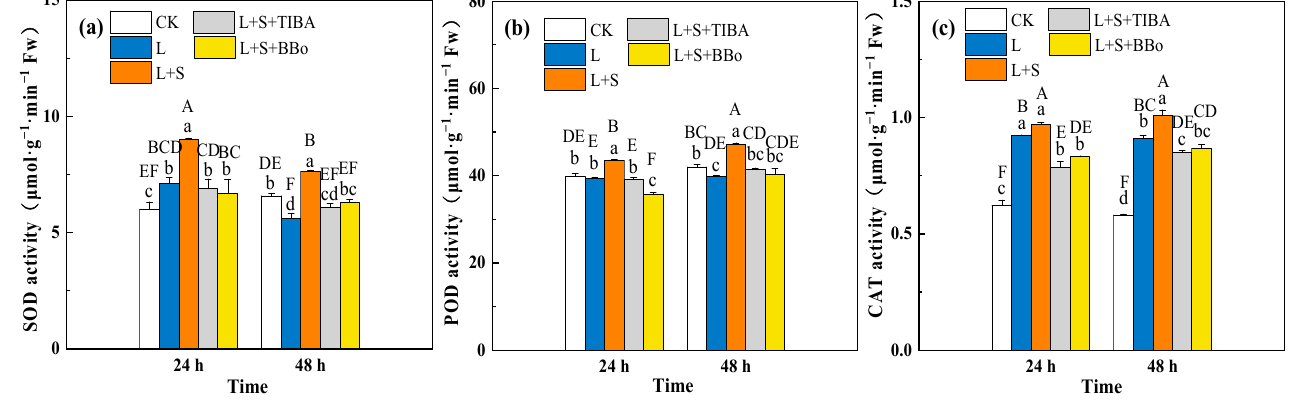
Figure 5. Effects of exogenous sucrose and IAA inhibitors on SOD ( a ), POD ( b ) and CAT ( c ) activities of M. baccata under sub-low temperature. Bars indicate means ± standard error ( n = 3). The lowercase letters represent significant differences between treatments ( p < 0.05). The capital letters represent significant differences between full data ( p < 0.05).The comparison of means is based on the Duncan’s multiple range test. CK, control treatment; L, sub-low root-zone temperature (5 ◦ C); L + S, 5 ◦ C + 90 mmol · L − 1 sucrose; L + S + TIBA, 5 ◦ C + 90 mmol · L − 1 sucrose + 500 µ mol · L − 1 2,3,5-triiodobenzoic acid; L + S + BBo, 5 ◦ C + 90 mmol · L − 1 sucrose + 300 µ mol · L − 1 4-biphenylboronic acid. (See Supplementary Materials).